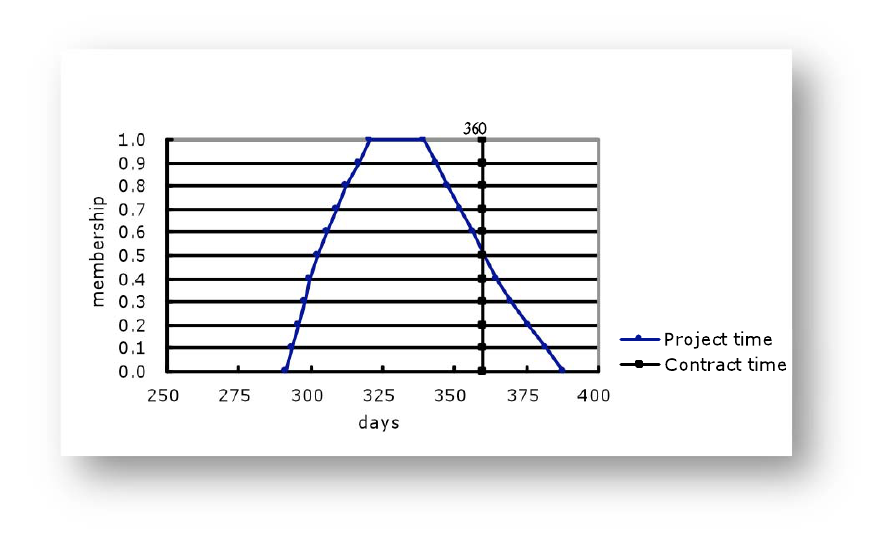
Figure 5. “Membership of overall project fuzzy time vs. contract